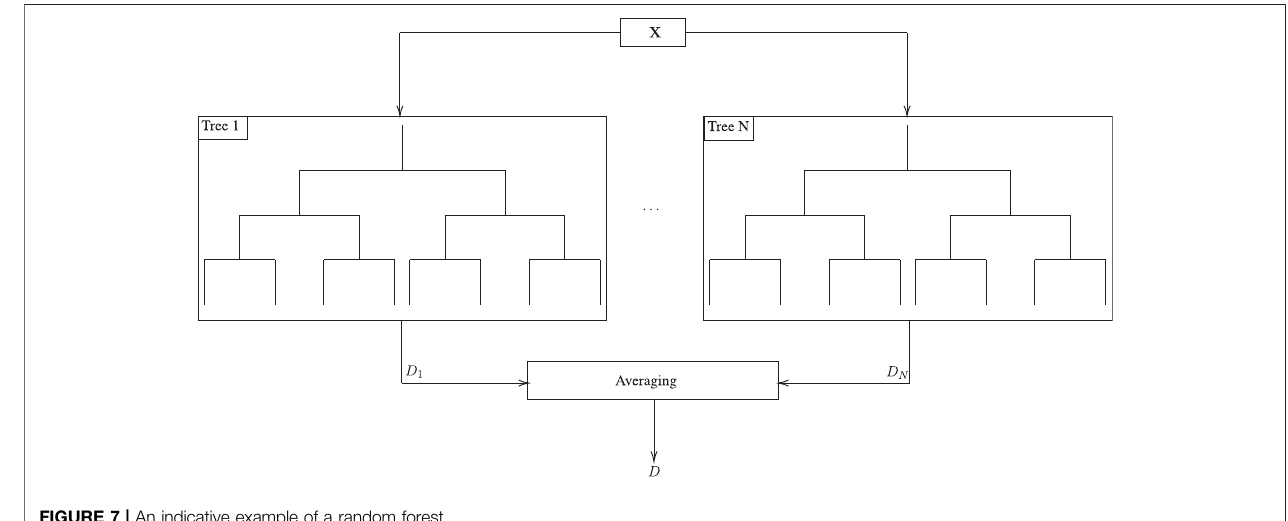
FIGURE 7 | An indicative example of a random